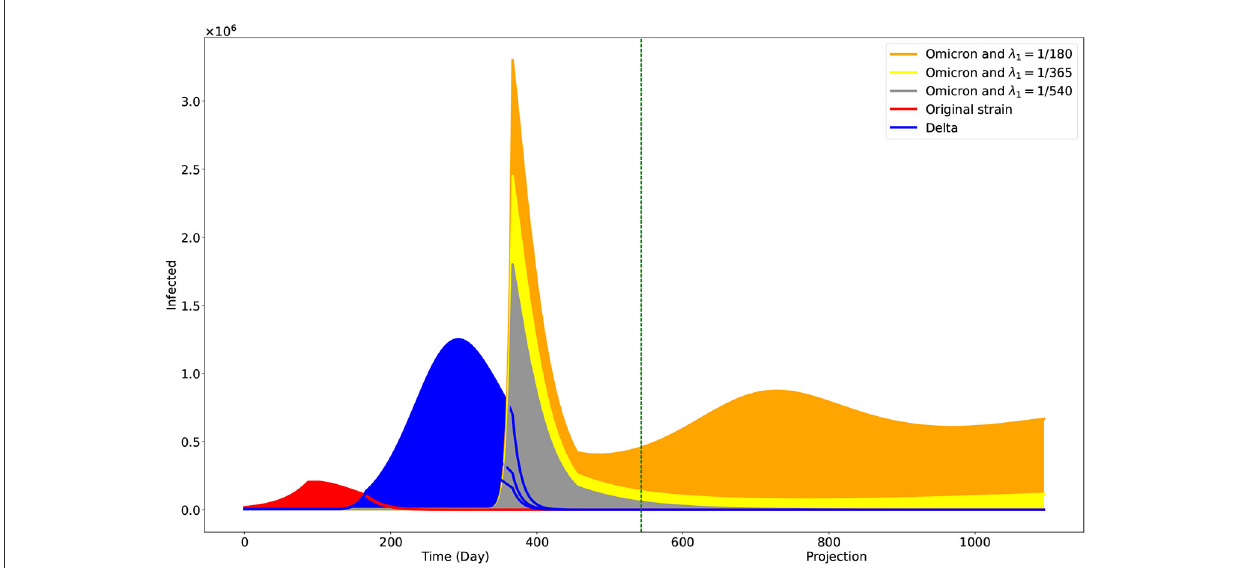
FIGURE4 Projection on the effects of different levels of vaccine-induced immunity duration. The green vertical line is at Day 543, the end of the data used. One may interpret the case when λ 1 = 1 / 180 to be the case when individuals only opt to be fully vaccinated. The cases λ 1 = 1 / 365 and λ 1 = 1 / 540 may correspond to the cases when individuals are also getting first and second booster shots,